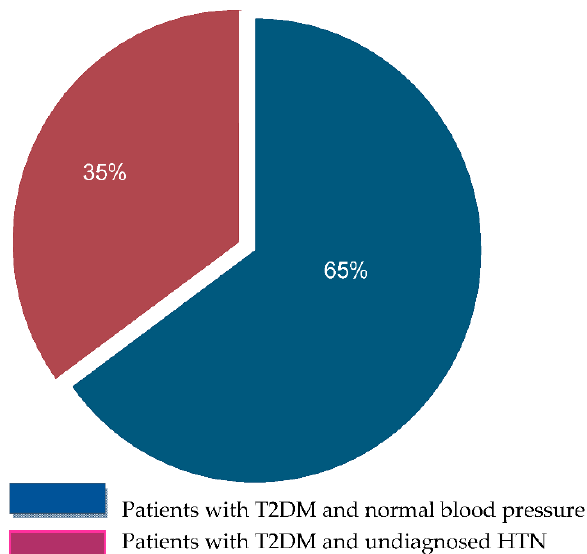
Figure 3. Individuals with T2DM under no antihypertensive medication. Table 3. Results of Pearson’s X 2 test for variables of the 24hABPM analysis